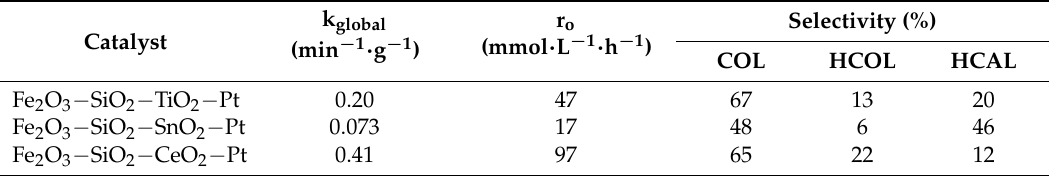
Table 2. Global pseudo-first order constant (k global ), initial reaction rate (r o ) and selectivity at 60% of